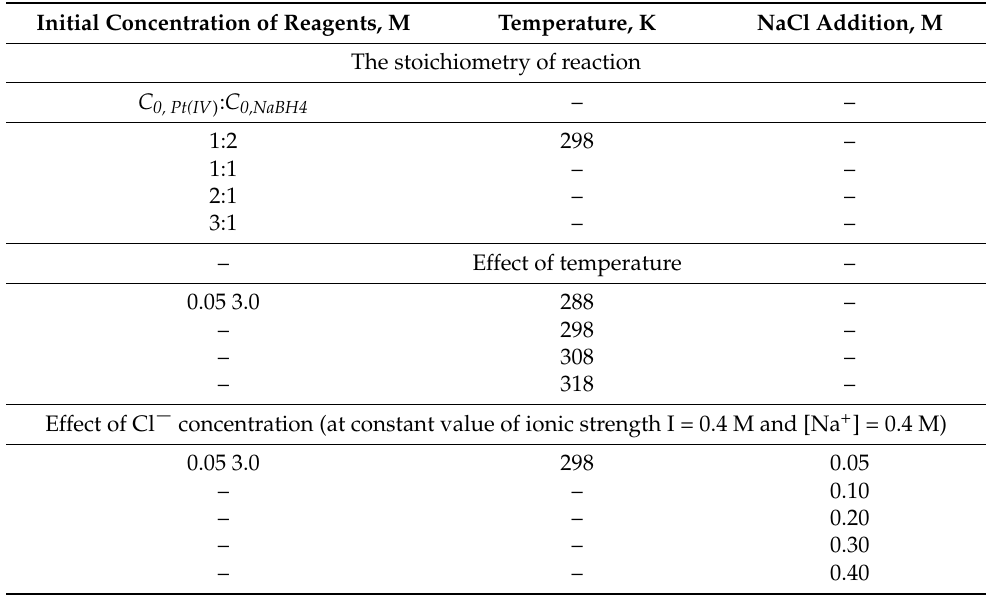
Table 1. Conditions of experiments for the reaction between platinum(IV) chloride complex ions and sodium borohydride. Conditions: pH = 12.9 ± 0.2, ionic strength I = 0.05 M (except, chloride addition). Initial Concentration of Reagents, M Temperature, K NaCl Addition, M The stoichiometry of reaction